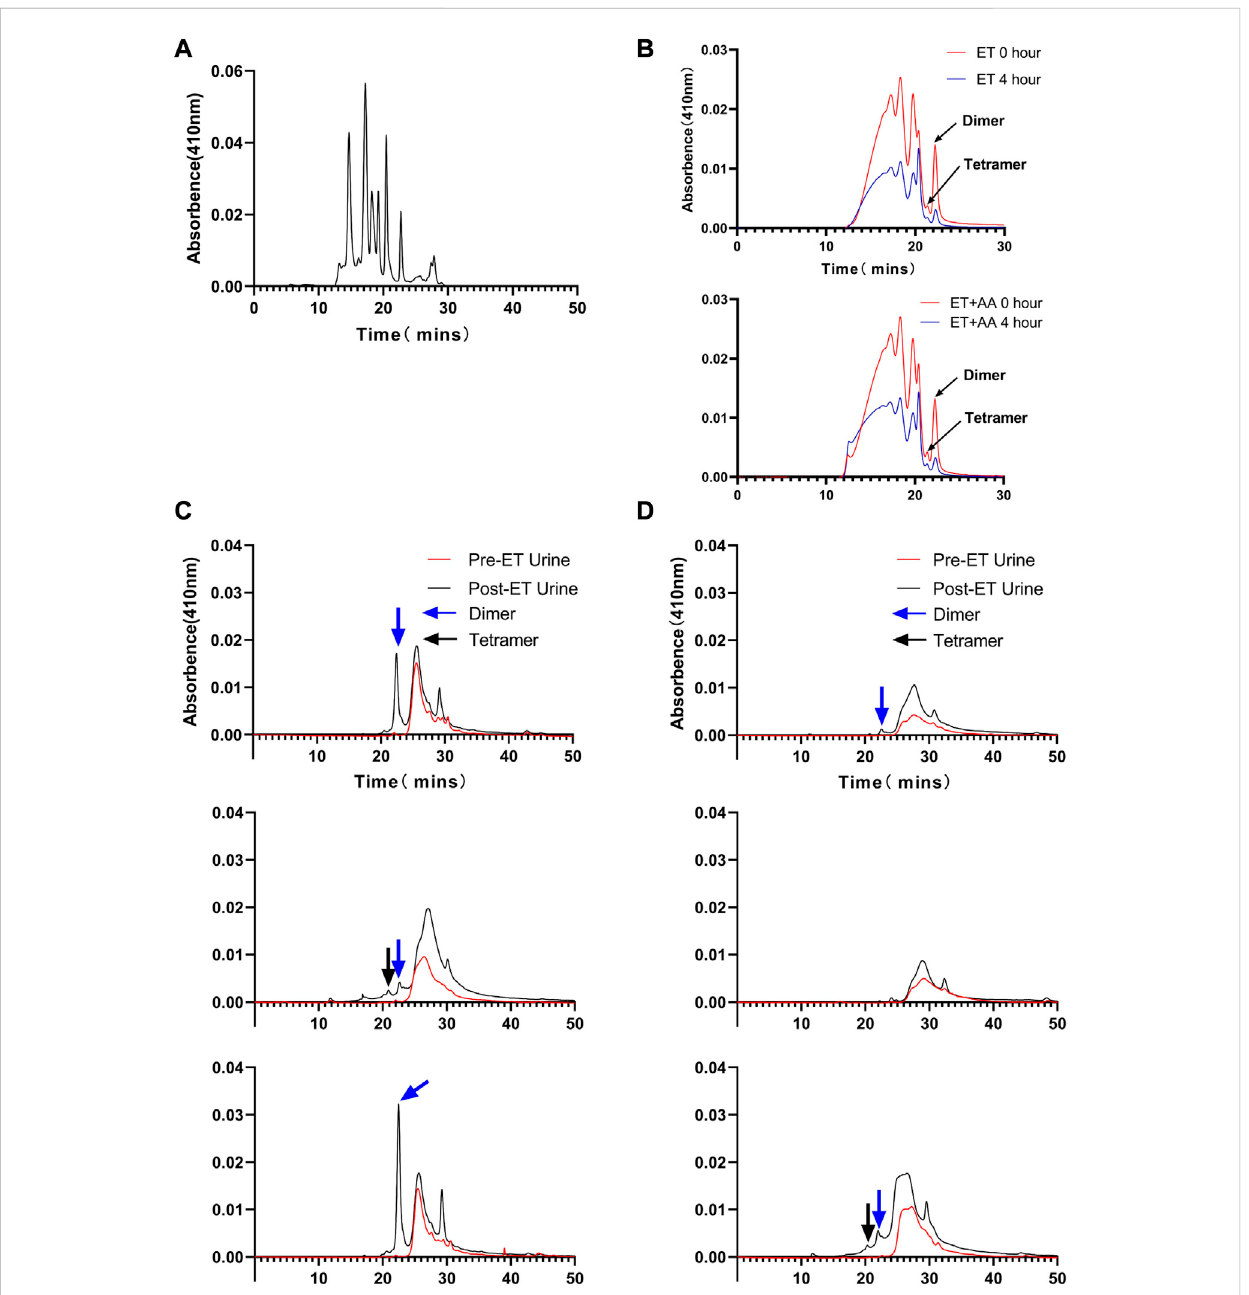
FIGURE 6 Size-exclusion chromatography distribution of heme in urine samples collected from ET group and ET + AA group. (A) Markers ran in parallel with samples. (B) Resultsof0and4 hpost-ETplasmasamples;theupperpanelisfromoneanimalintheETgroup,thelowerpanelisfromoneanimalintheET + AA group. (C) Results of three samples collectedfrom single animals inthe ET + AA group. (D) Results ofthree samples collected from single animals in the ET